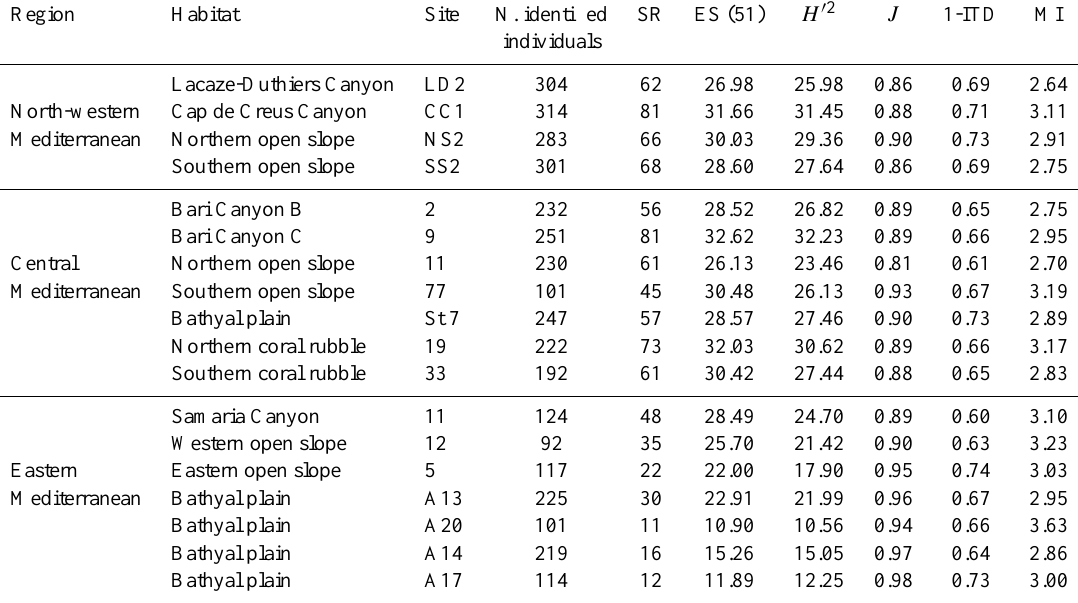
Table 2. Nematode diversity indices, calculated cumulatively from the individuals retrieved from the three replicates of the investigated sampling sites. SR, species richness; ES(51), expected species number for 51 individuals; H 0 2 , Shannon’s index; J , species evenness; 1-ITD, index of trophic diversity; MI, maturity